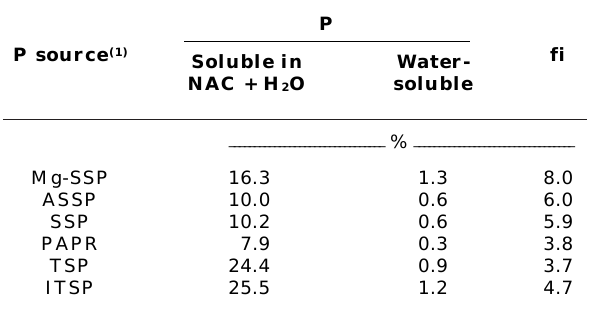
Table 2. Soluble phosphorus in NAC + H O, water- 2 soluble P and percentage of water-soluble in relation to NAC + H O-soluble P (“fi”) of 2